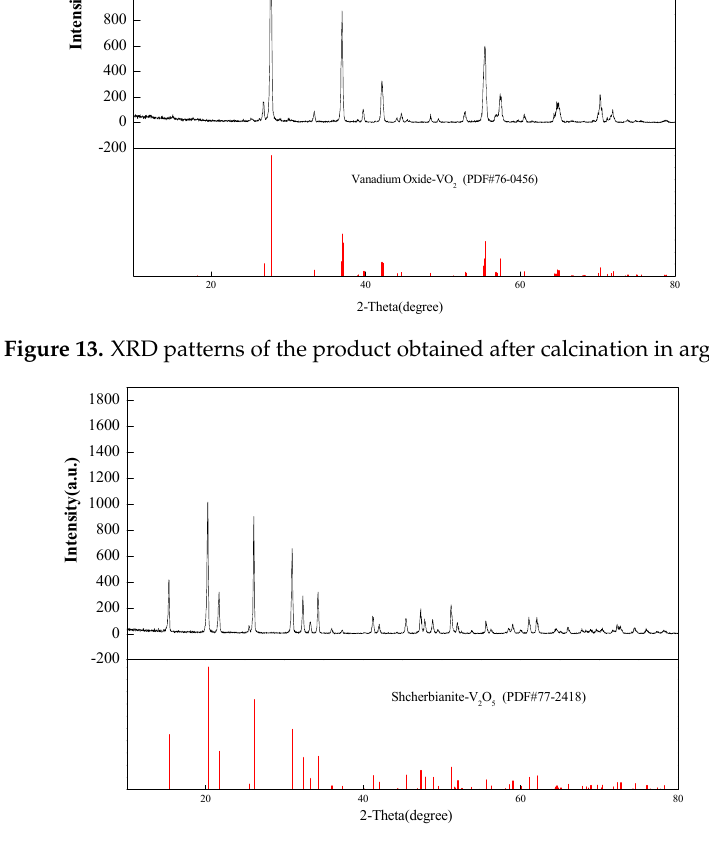
Figure 14. XRD patterns of the product obtained after calcination in air.